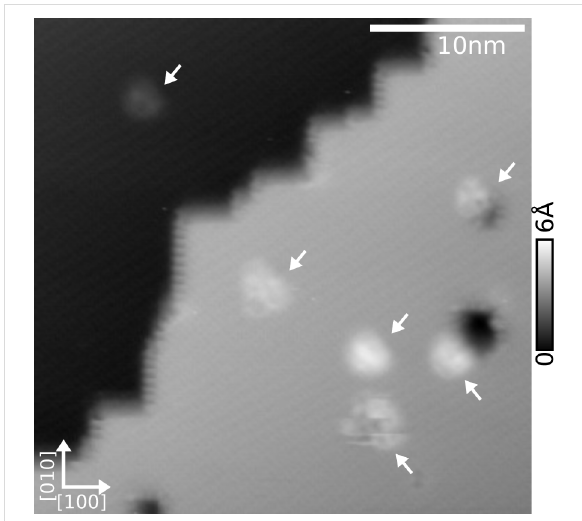
Figure 6: Topography image (40 × 40 nm 2 ) of the KBr(001) surface with a low coverage of diporphyrin molecules deposited by UHV-ESI for 2 min. Parameters: f 2nd = 1.02 MHz, A 2nd = 400 pm, Δ f 2nd = − 57 Hz.